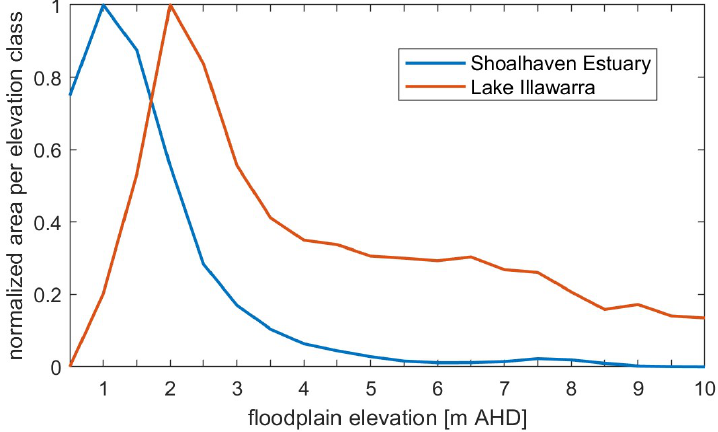
Figure 7. Distribution of estuarine floodplain elevation (0–10 m AHD) for Lake Illawarra and the Shoalhaven Estuary. Floodplain elevation was reclassified to intervals of 0.5 m and the corresponding areas per class normalised to scale the data.